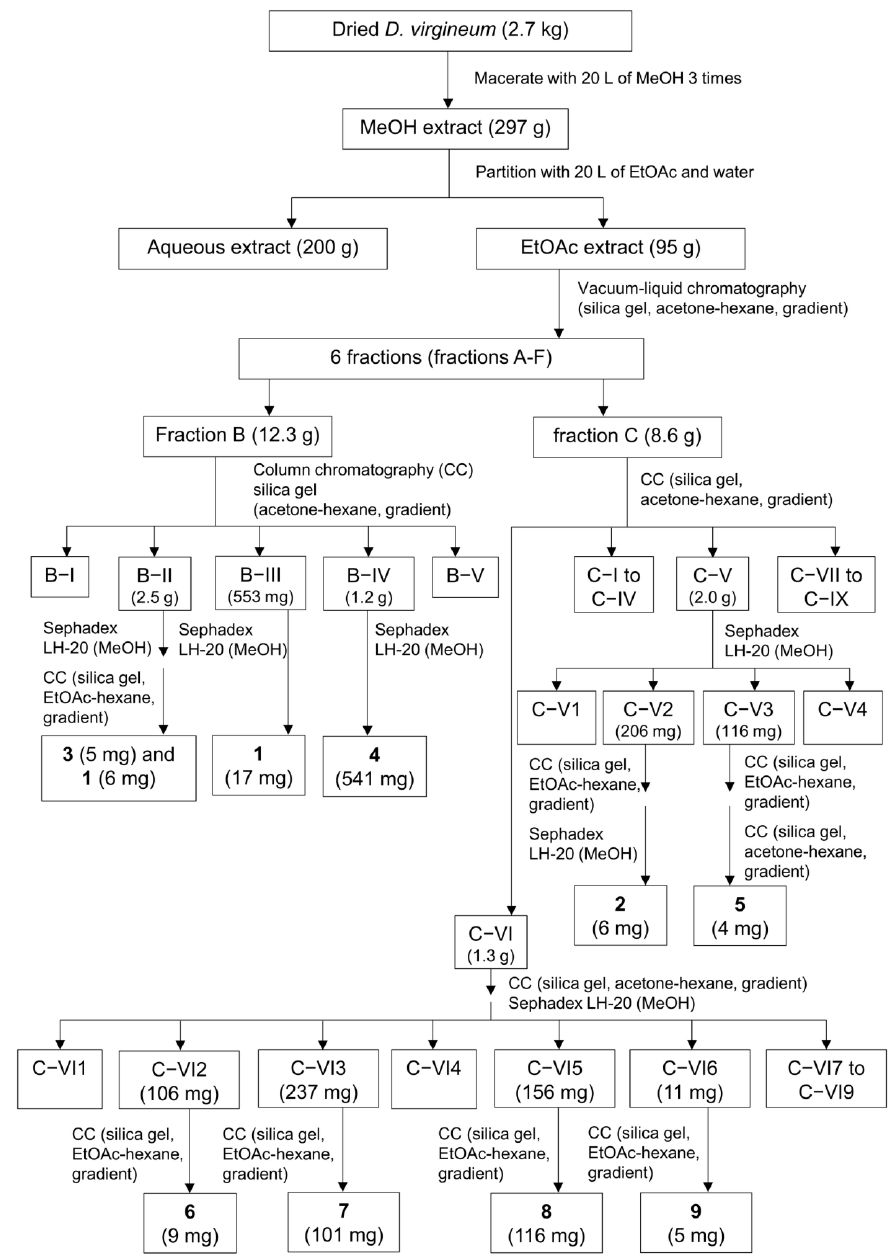
Scheme 1. Extraction and isolation of compounds from Dendrobium virgineum . Dendrovirginone ( 2 ): Red amorphous solid; UV (MeOH) λ max (log ε ): 222 (4.39), 260 (4.07), 334 (3.79), 490 (3.53) nm; IR (film) ν max : 3416, 2939, 2922, 1722, 1658, 1605,